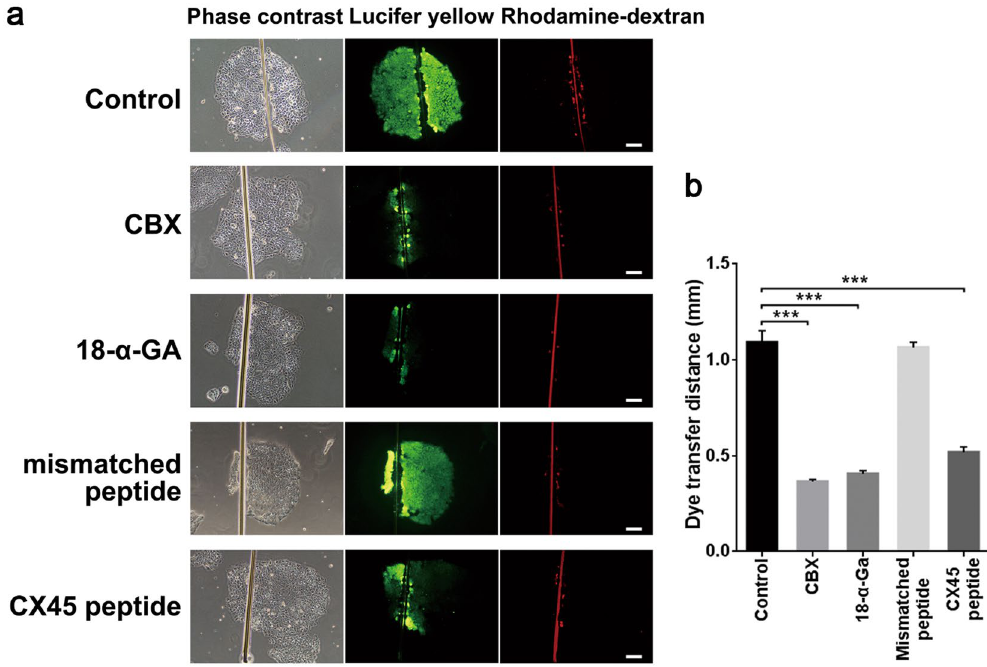
Figure 1. GJIC in human iPSCs. ( a ) Phase-contrast and fluorescence micrographs with Lucifer yellow and rhodamine-dextran. Human iPS cells were incubated in the absence or presence of CBX, 18- α -GA, the mismatched mimetic peptide and CX45 mimetic peptide. Scale bar = 200 μ m. ( b ) The histogram shows